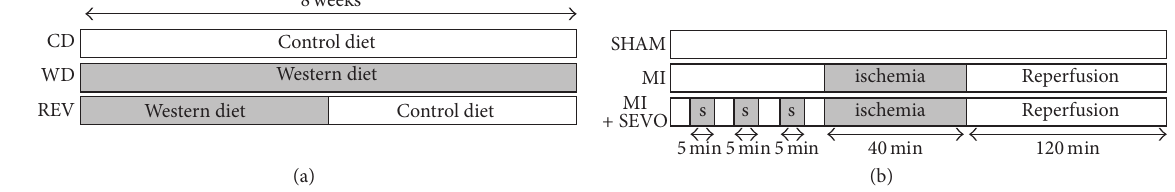
Figure 1: Experimental protocol. Rats were fed a control diet (CD) or western diet with sucrose water (WD) for 8 weeks. A third group of WD-fed rats reversed after 4 weeks to CD for 4 consecutive weeks (REV) (a). After 8 weeks of diet exposure, animals underwent left coronary artery occlusion for 40 min followed by 120min of reperfusion without (MI) or with 3 × 5 min sevoflurane (s) exposure (MI + SEVO)